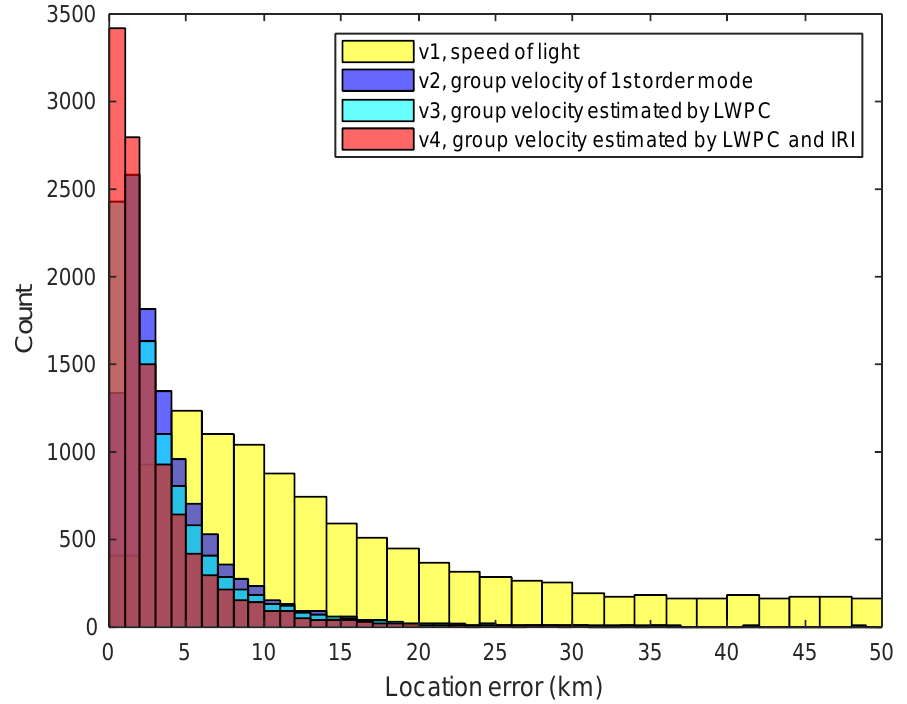
Figure 4. The histograms of lightning location errors corresponding to different group velocities: the speed of light ( v 1 ), the group velocity of 1st order mode ( v 2 ), the group velocity calculated by LWPC model ( v 3 ), and the group velocity calculated by LWPC and IRI models ( v 4 ). The distances between the four stations of ELLN vary from 2000 to 4000 km, and the histogram distributions of the minimum, mean and maximum distances from the light- ning events to the stations are shown in Figure 5. Among them, the minimum distances range from 0 – 1700 km, the mean distances range from 1300 – 2800 km, and the maximum distances range from 1500 – 4500 km. The statistics in Figure 5 show that the distance of lightning events varies considerably under different definitions. To better and quantita- tively reveal how the positioning errors vary with distance, we define the maximum dis- tance from a lightning event to the ELLN stations as the distance from the event to the ELLN network in all subsequent analyses. According to this definition, the vast majority of distances corresponding to all lightning localization events in Figure 3 are distributed in the range of 1500 to 4000 km.